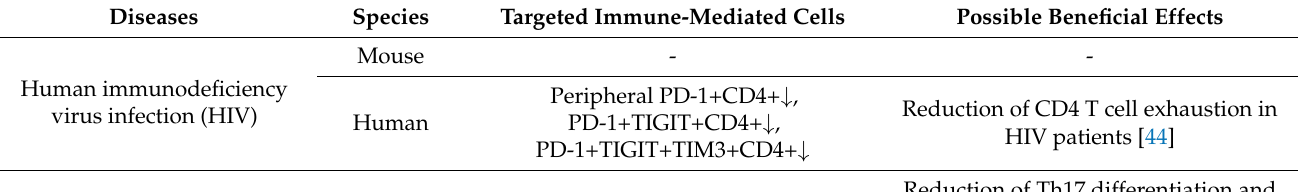
Table 1. Effects of metformin in infection and immune-mediated